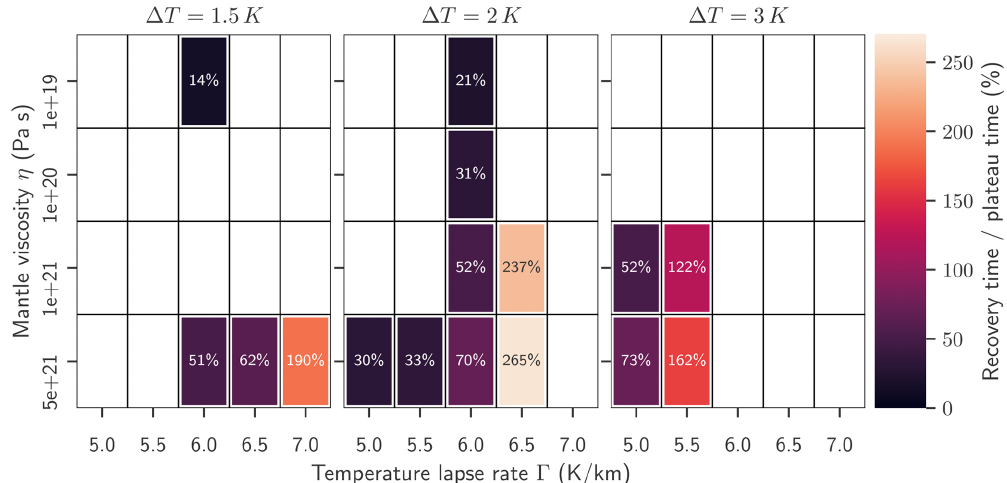
Figure 5. Ratio of recovery time vs. plateau time for three different warming temperatures, (cid:49)T = 1 . 5, 2 and 3K. Measure for how long the lower half of the oscillation is compared to the upper half. A ratio of 100% would signify a perfectly symmetric oscillation: the lower the number, the more time spent in a recovered regime (ice volume greater than the average of minimal and maximal oscillation volume), and the higher the number the more time spent at low ice volumes (ice volume less than the average of minimal and maximal oscillation